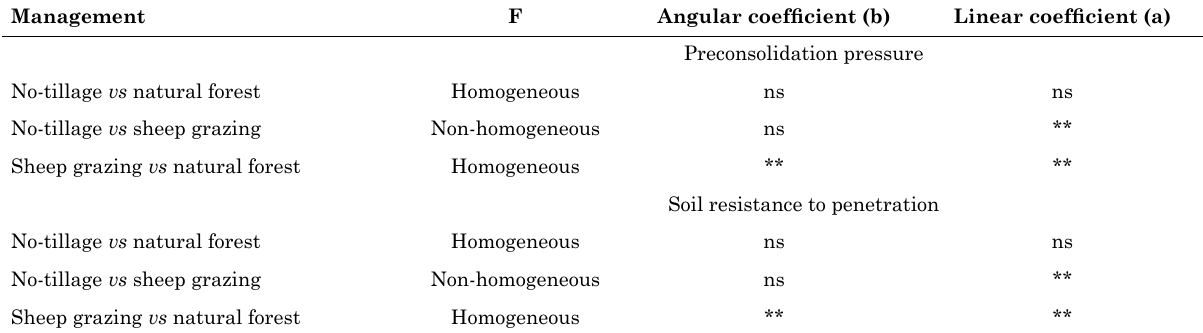
Table 2. Snedecor and Cochran significance test among preconsolidation pressure modeling and coefficients of models fitted to soil resistance to penetration in Latossolo Vermelho-Amarelo distrófico